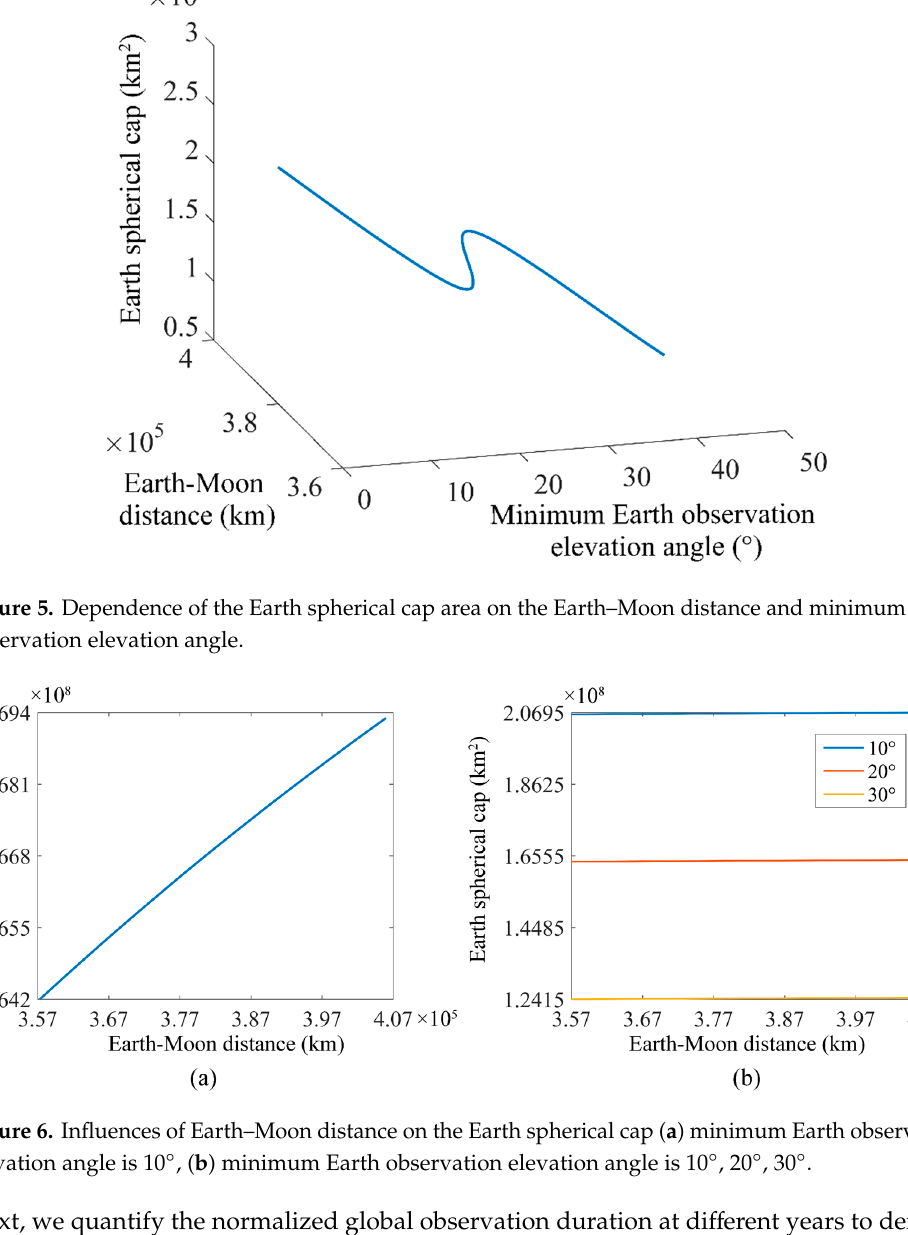
Figure 4. Global observation coverage from (0°,0°) on the lunar surface at ( a ) 00:00; ( b ) 08:00; ( c ) 16:00 UTC on 1 January; ( d ) 00:00; ( e ) 08:00; ( f ) 16:00 UTC on 2 January 2021. The light part means that these regions are visible for a Moon-based sensor, which changes with the positions of nadir point; the dark part represents the opposite.